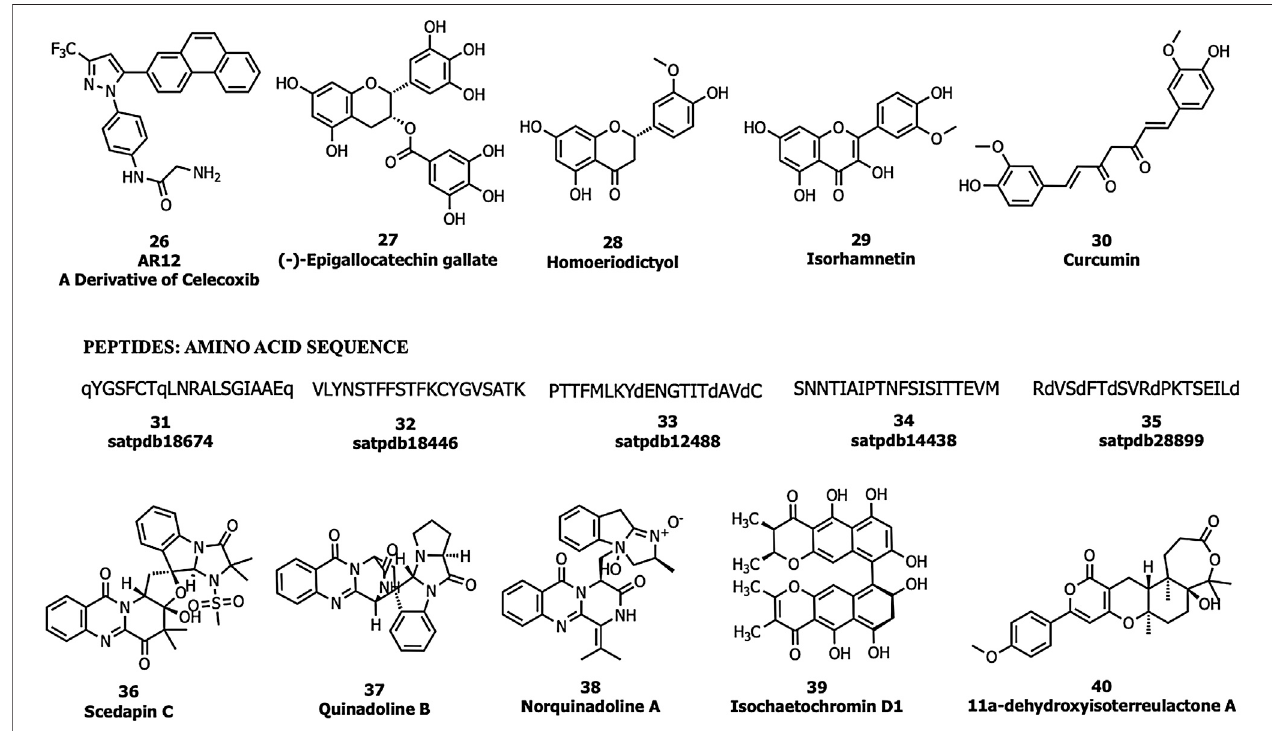
FIGURE 10 | GRP78